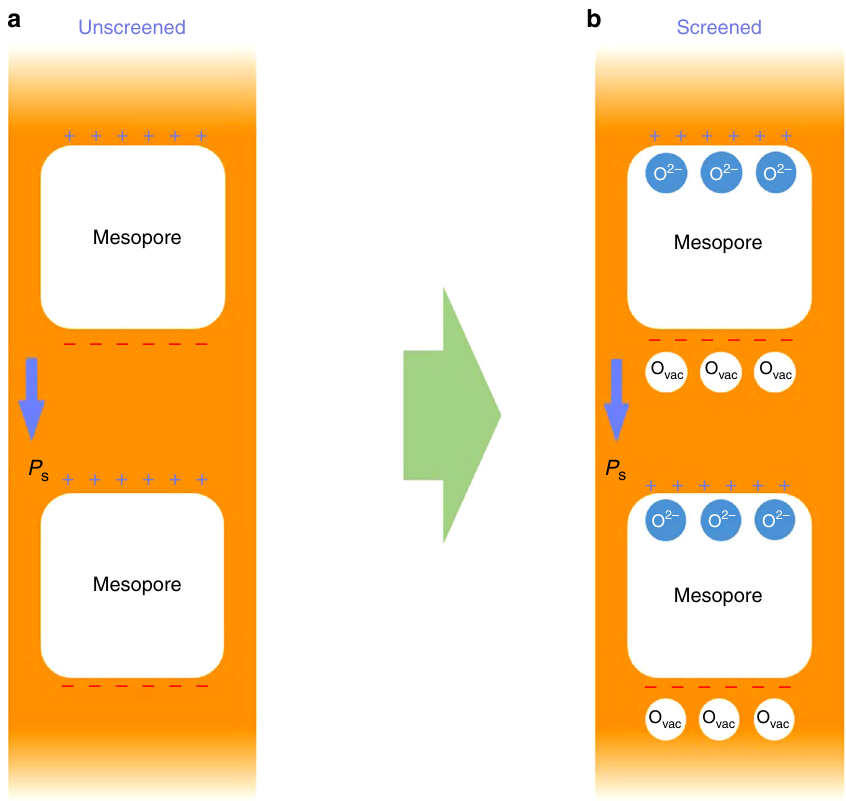
Fig. 4 Scheme illustration of oxygen-based polarization screening mechanism in mesopores. a Unscreened mesoporous PTO fi ber. b Screened mesoporous PTO fi